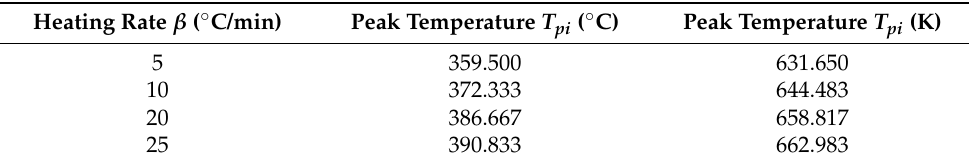
Table 1. Peak temperature of DTG curve at different heating rates.